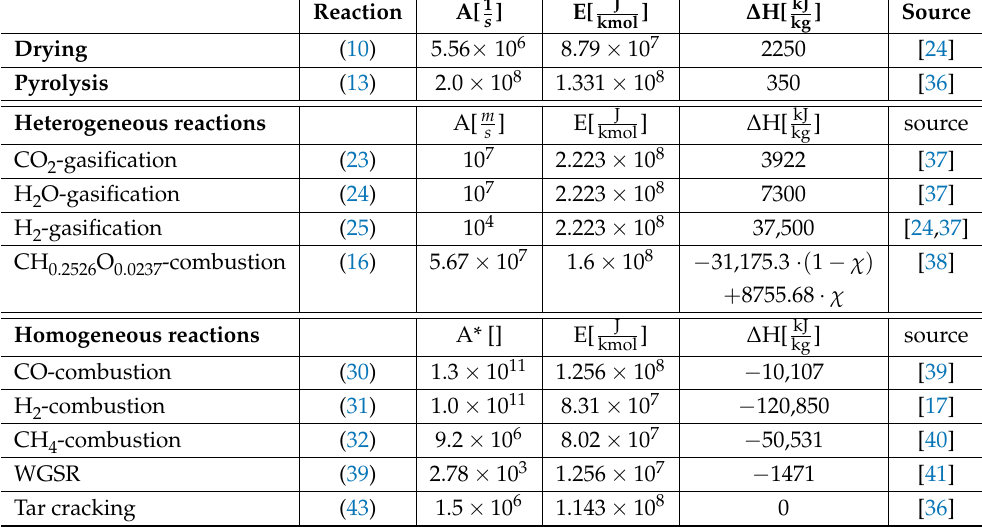
Table 2. Kinetic data and heats of reaction for drying, pyrolysis, heterogeneous and homogeneous